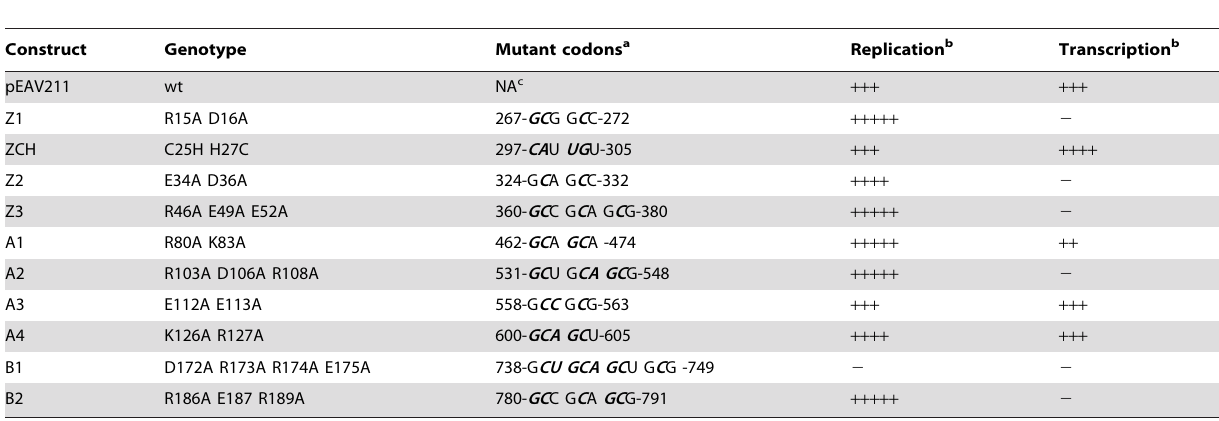
a Nucleotide substitutions are indicated in bold italics; numbers indicate the start and end coordinates of the mutated codons in the EAV genome. b Transfected cells were analyzed by IFA and gel hybridization analysis at 11 h post-transfection. Wild-type levels of replication and transcription (based on accumulation levels of genomic and sg mRNAs, respectively) are indicated with +++ . A 2- to 4-fold increase in genomic RNA levels as compared to wild-type is denoted by ++++ , while an increase of . 4-fold is shown as +++++ . Likewise, a . 2-fold increase or decrease in accumulation levels of at least two sg mRNA species is shown as ++++ and ++ , respectively (see text for details). c NA, not